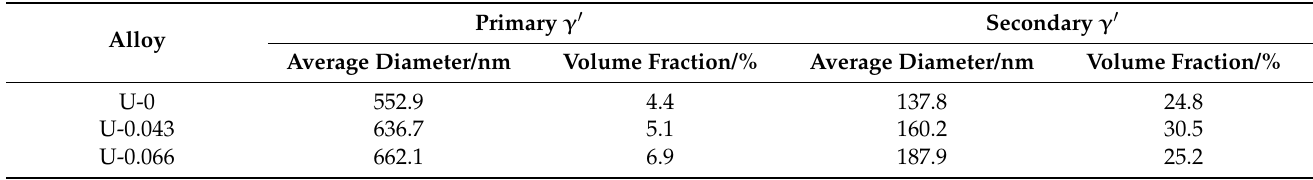
Table 4. The size and volume fraction of primary and secondary γ (cid:48) in Sc-doped